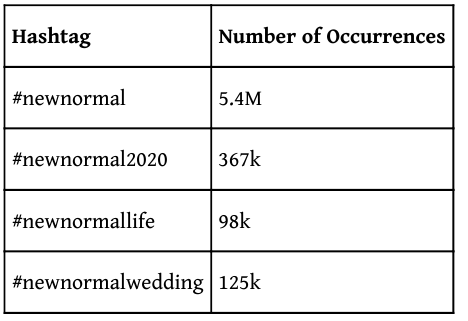
Table 1: Chosen hashtags under the base tag #newnormal